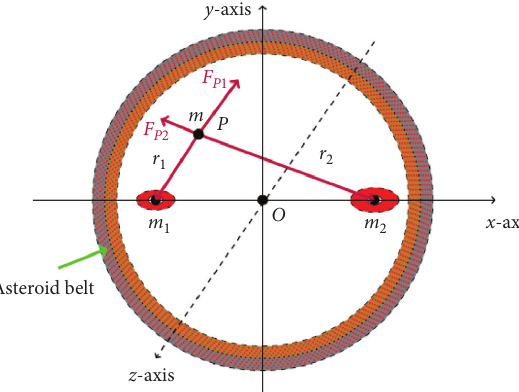
Figure 1: Geometric configuration of the problem with asteroid